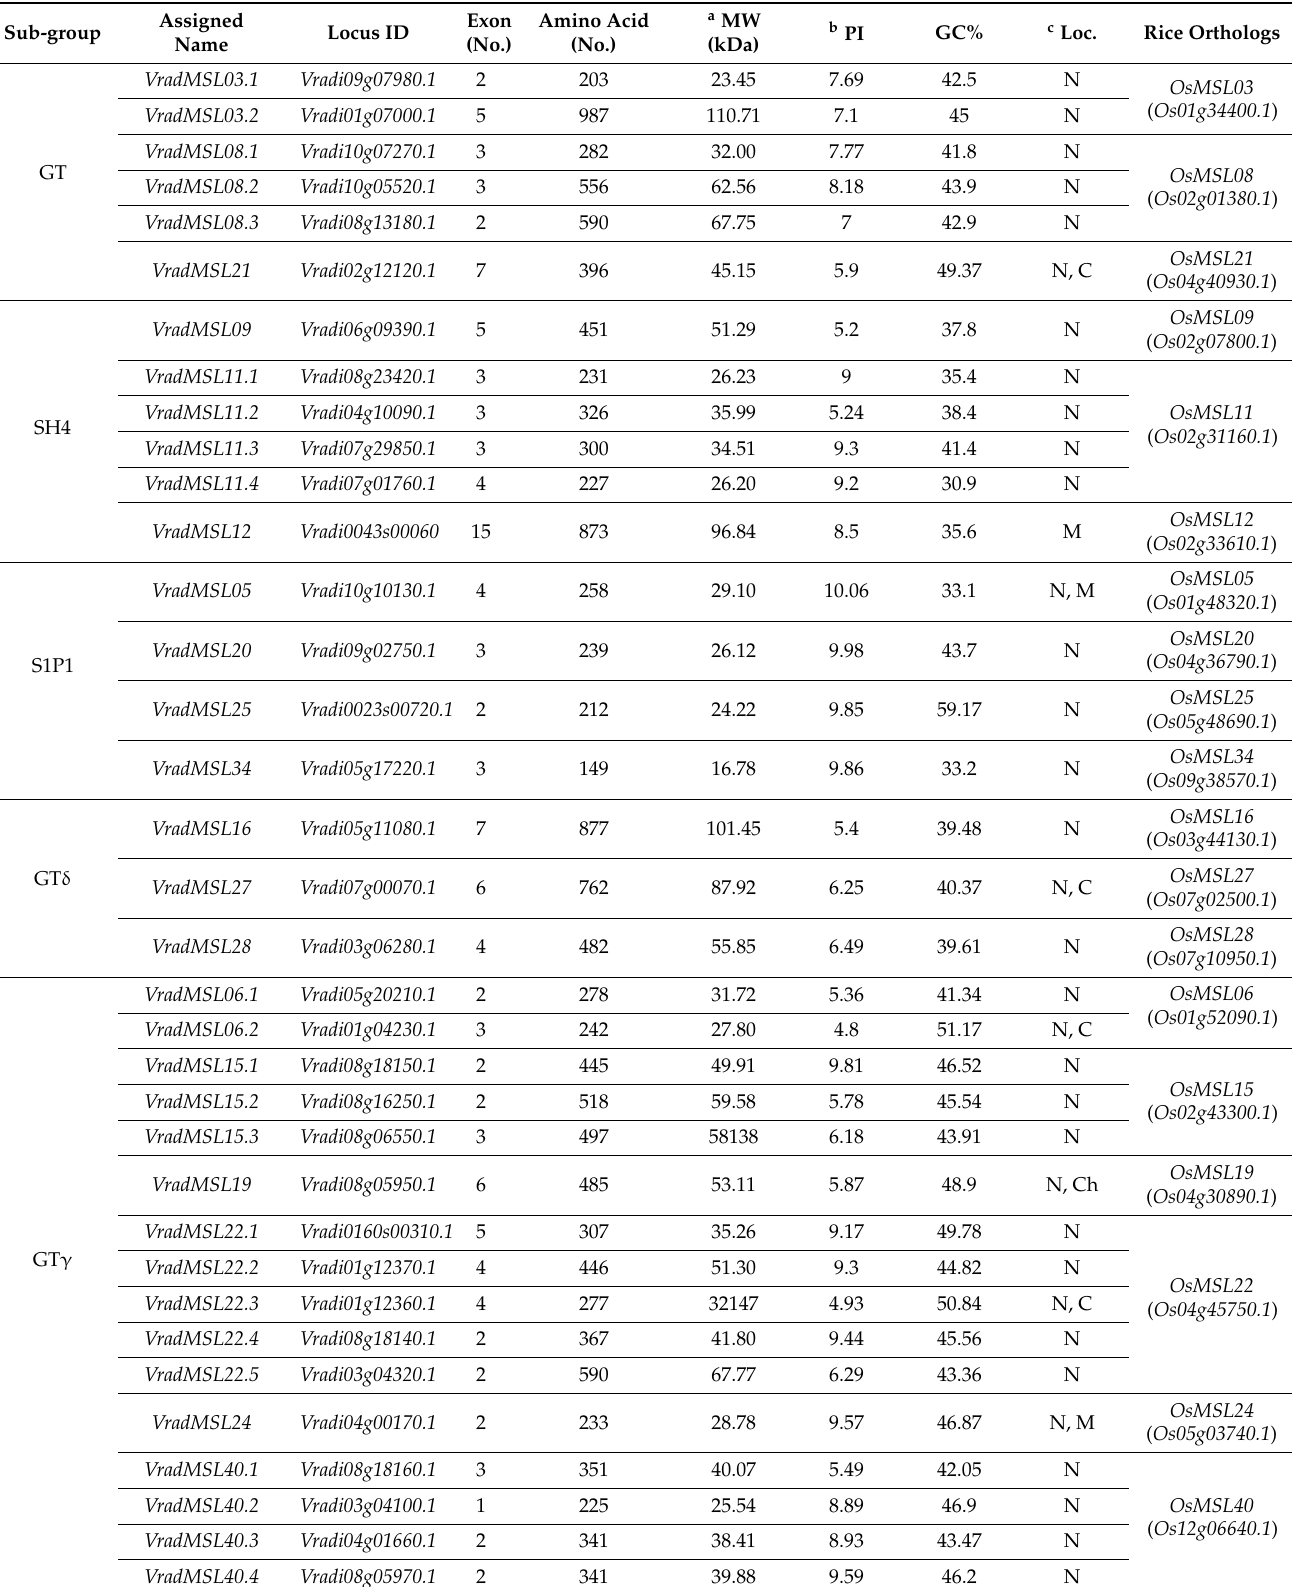
Table 2. Basic characteristics of Vigna radiata Trihelix